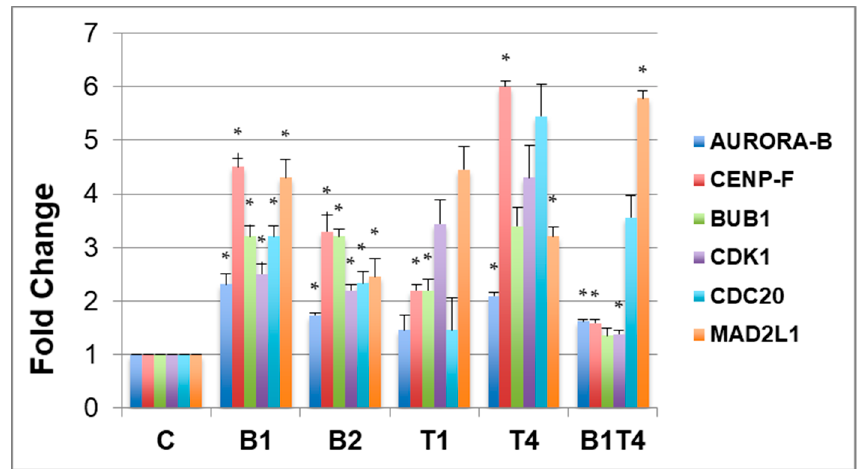
Figure 4. Validation of upregulation for major checkpoint protein transcripts upon Btf and/or TRAP150 depletion. RNA samples from HeLa cells treated with control siGENOME2 (C), Btf siRNA duplexes (B1, B2), TRAP150 siRNA duplexes (T1, T4), or Btf + TRAP150 siRNA duplexes (B1T4) were used for RT-qPCR analysis to validate alterations in transcripts that encode mitotic regulator proteins. * p -Values ≤ 0.05 for each respective gene compared to its level in control samples (e.g., aurora-b in sample B1T4 compared to Aurora-B in sample C).